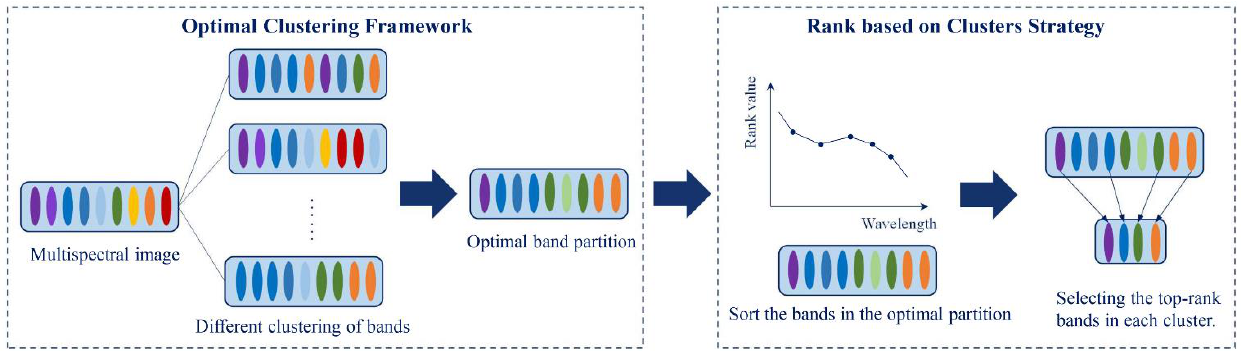
Figure 4. The flow chart of the OCF algorithm (in the figure, each color refers to a cluster of bands). First, the optimal band partition via OCF is based on the given objective function. Then, all the bands are evaluated through an arbitrary ranking method. Finally, the top-rank bands are selected in each cluster.